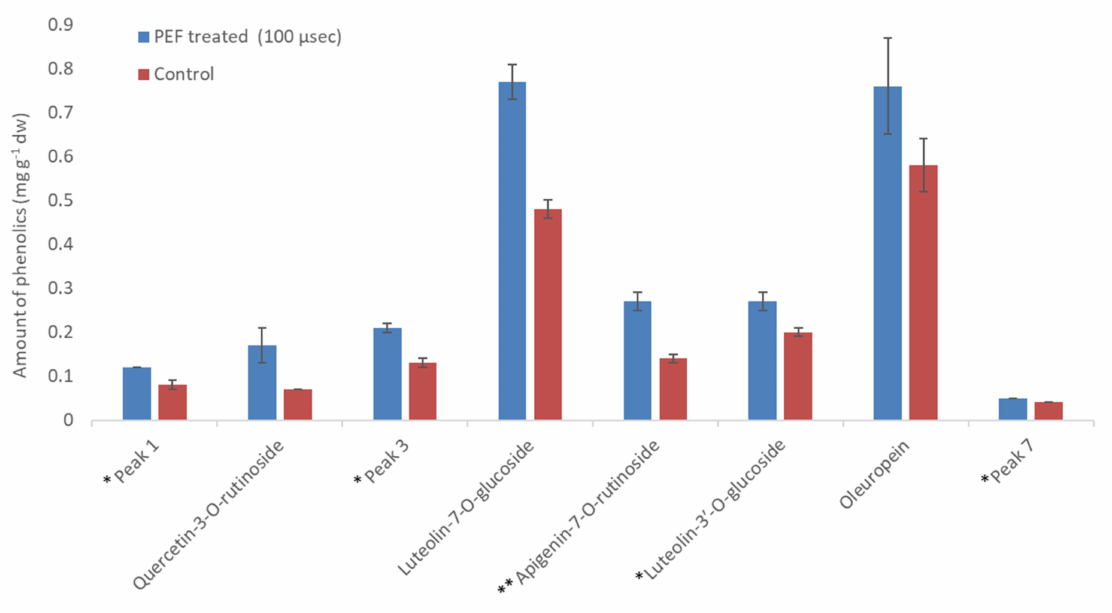
Figure 10. Amount of phenolics (mg g − 1 dw) in PEF treated leaves versus control at 100 µ s pulse duration and 25% EtOH. * Luteolin-3 (cid:48) -O-glucoside and peaks 1, 3 and 7 were quantified as luteolin-7-O-glucoside; ** Apigenin-7-O-rutinoside was quantified as